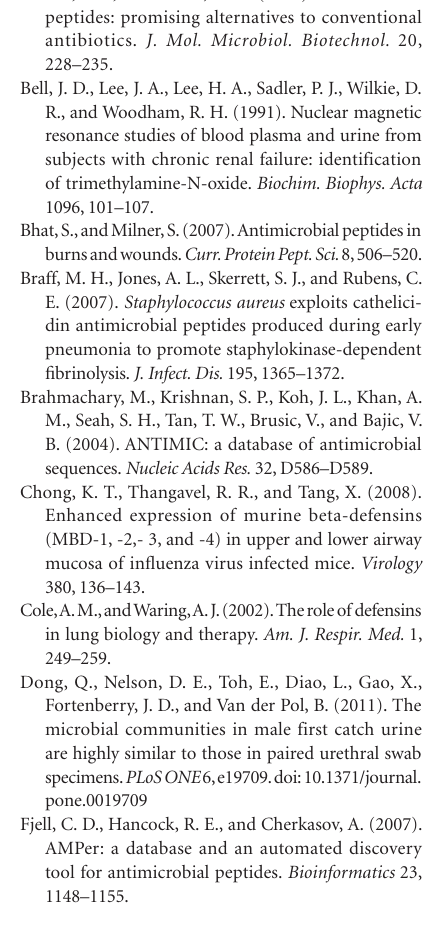
integrated to design better diagnostic tools, therapeutic options, or prognostic indicators for patients with cancer, wounds, infections, or